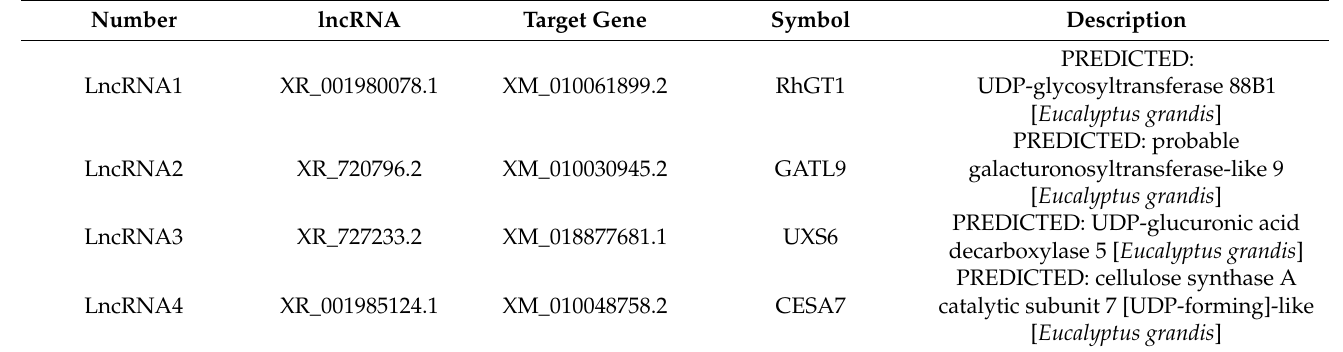
Table 1. Synthesis of Eucalyptus grandis cellulose related lncRNAs.